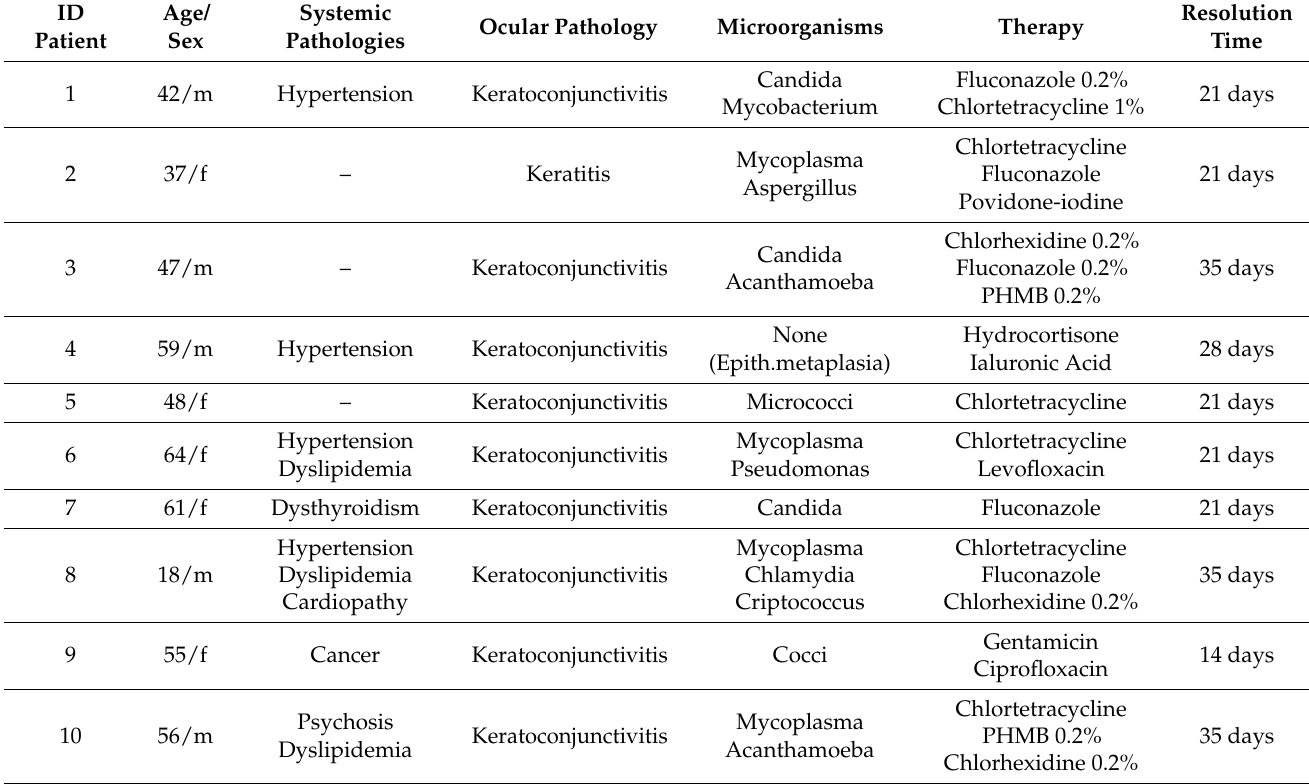
Figure 1. SEM examination: Presence of microorganisms in scraping of the superior tarsal conjunctiva. Table 1. Clinical data of the examined